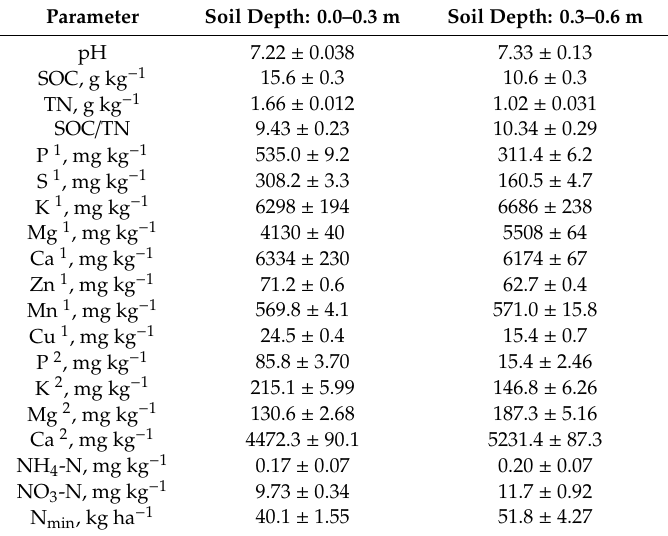
Table 1. Soil properties (mean ± standard error of the mean) of experimental site after harvest of preceding crop and before setting up the experiment, August 2012 ( n =